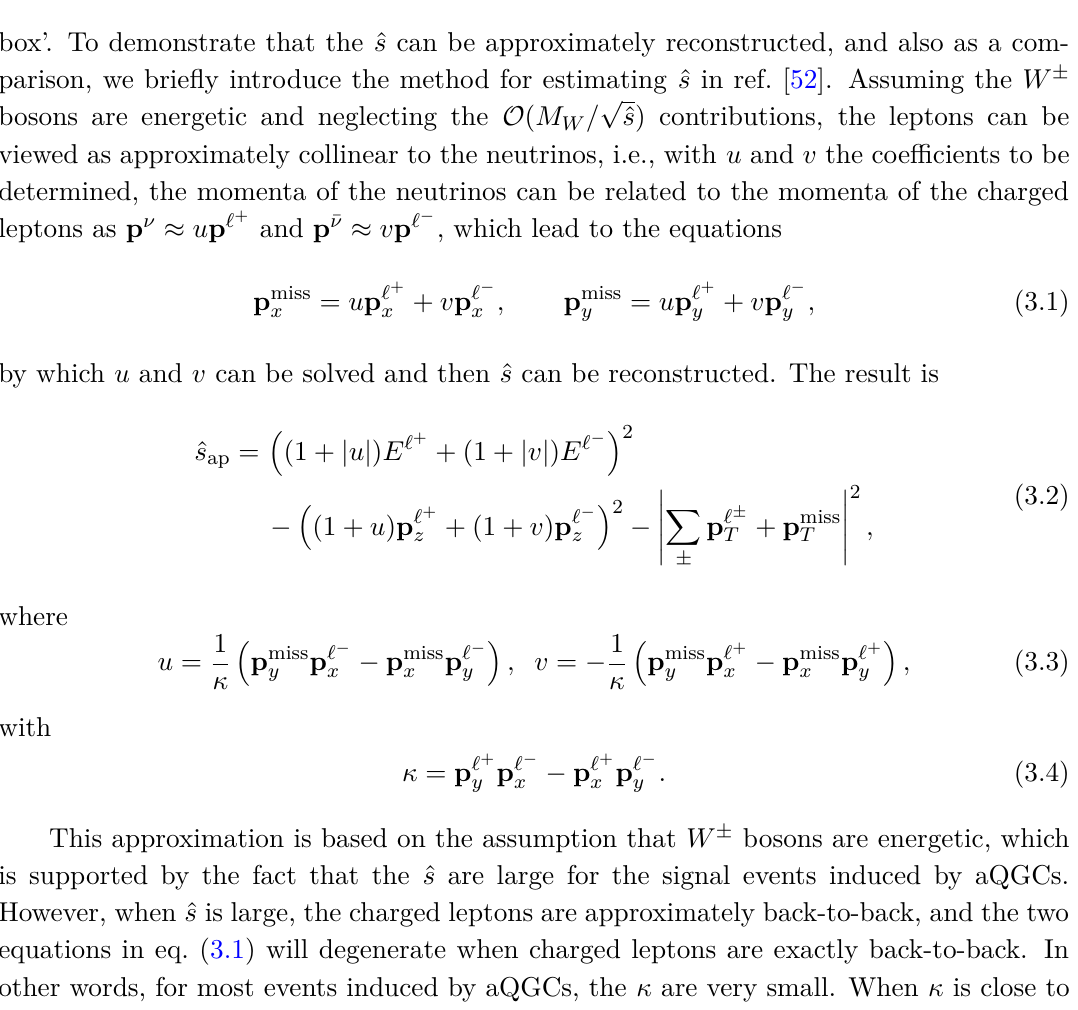
Figure 1 . The Feynman diagrams of the contributions from anomalous γγWW couplings to the process pp → jj‘ + ‘ − ν ¯ ν